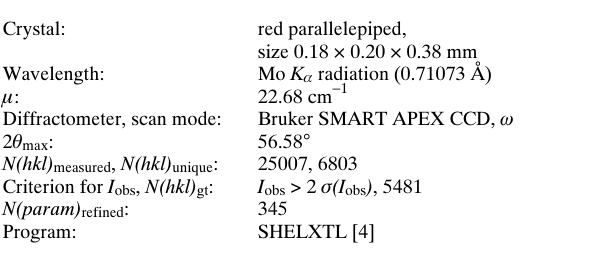
Table 1. Data collection and handling.